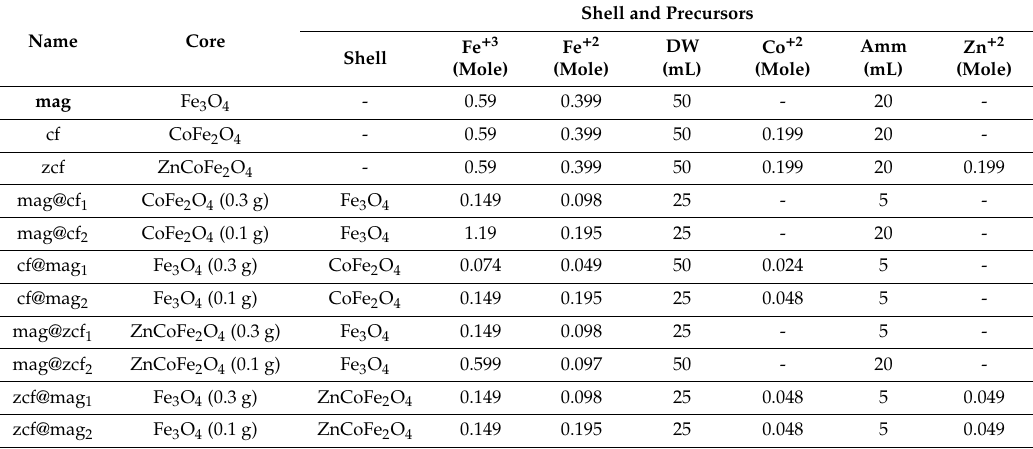
Table 1. Nomenclatures and synthetic compositions of various core nanoparticles and core-shell magnetic ferrite nanoparticles